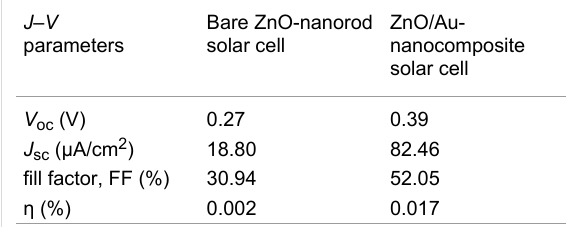
Table 1: J–V characteristics of bare ZnO-nanorod and ZnO/Au- nanocomposite solar cells in the absence of dye N719, measured at an illumination of 1 sun, AM 1.5 G (100 mW/cm 2 ).